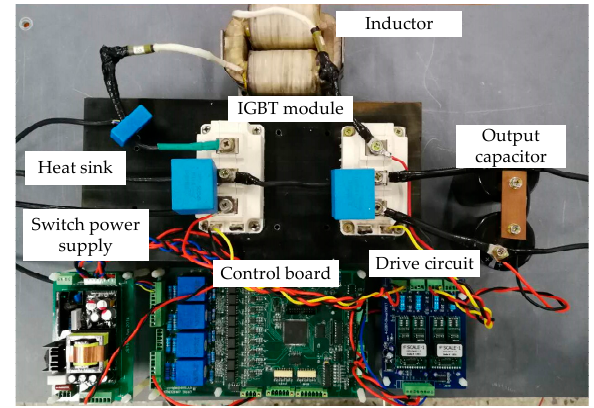
Figure 7. Experiment hardware circuit.